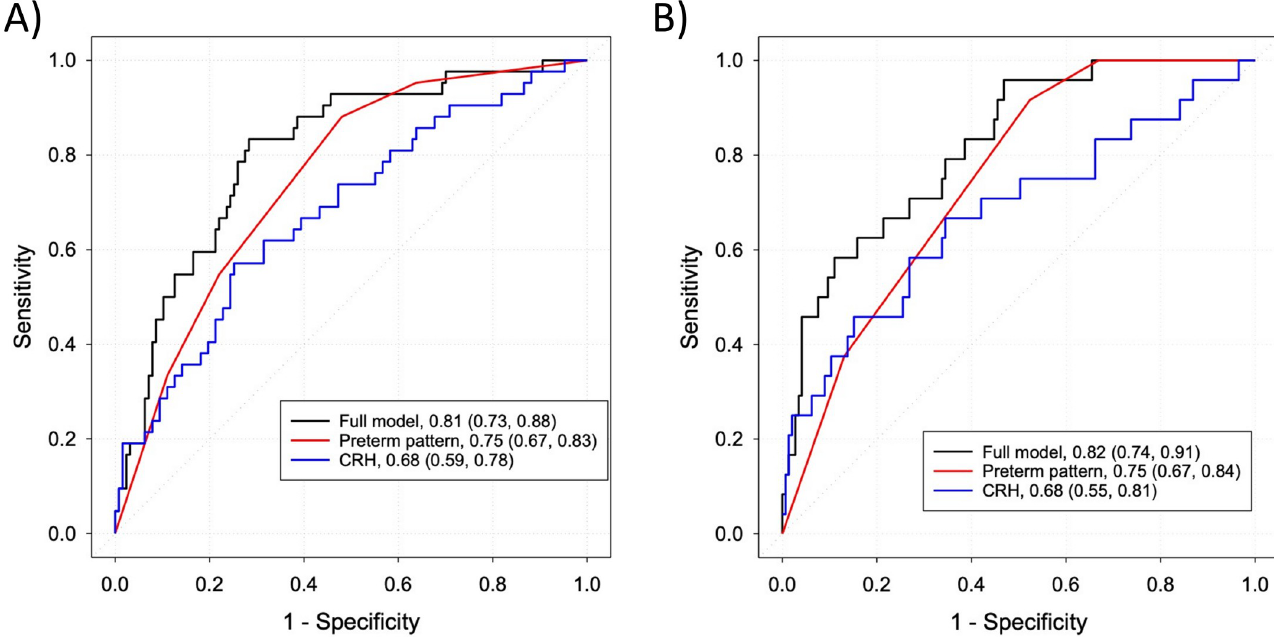
Fig 5. Receiver operator characteristic curves for plasma corticotrophin-releasing hormone levels and prior preterm birth history at 24 weeks based on delivery outcome of (A) < 37 weeks and (B) < 35 weeks. Green line = CRH alone. Red line = preterm birth history alone. Blue line = combination of CRH and prior preterm birth history. Area under the curve (AUC) statistics is 0.68 (95% CI 0.59–0.78) and 0.70 (95% CI 0.59–0.81) for CRH alone, at 24 (N = 169) and 32 (N = 113) weeks respectively, and 0.81 (95% CI 0.73–0.88, P = .001) for delivery < 37 weeks and 0.82 (95% CI 0.74–0.91) for < 35 weeks when CRH and prior preterm birth history are combined. The AUC combining CRH and prior preterm birth history is significantly different than that with CRH alone (P = .001 for < 37 weeks and < .001 for < 35 weeks).